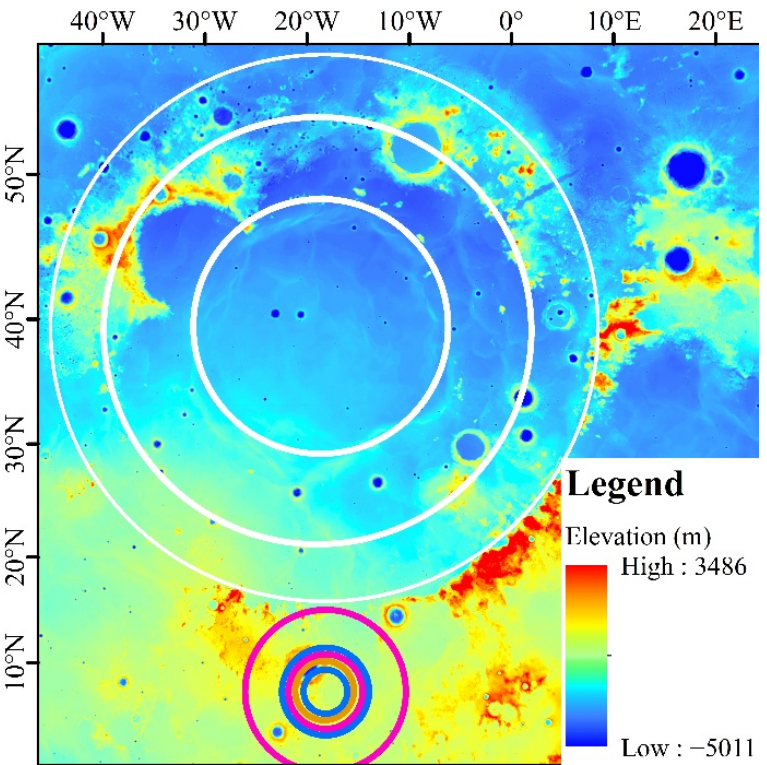
Figure 12. Previous study results and the Imbrium basin, shown on the LROC WAC DTM GLD100. Blue circles from Neumann et al.; pink circles from Evans et al.; orange circle from Liu et al. White circles from Neumann et al. are rims of the Imbrium